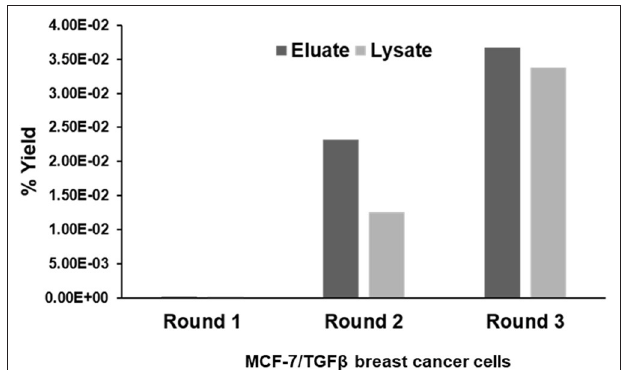
FIGURE 2 | Specific enrichment of eluate and lysate MCF-7/TGF β cell-binding phage isolated from PhD CX7C library during three rounds of selection. The titer of recovered phages from each round was evaluated by blue plaque-forming assay on agar plates. The phage enrichment rate was calculated as yield (%), which is as output number/input number x100.